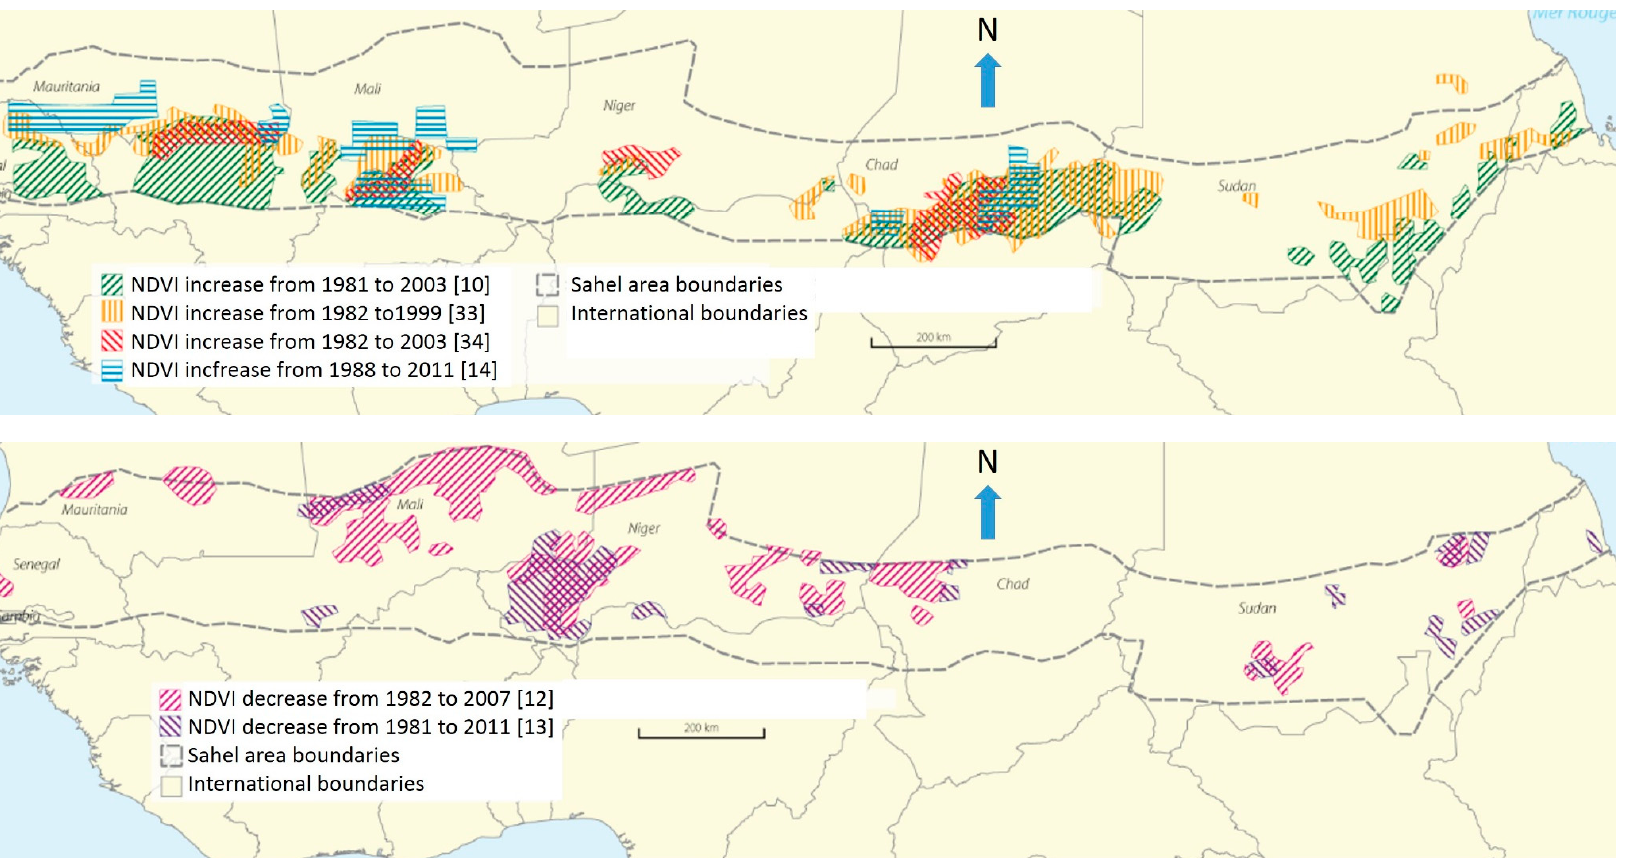
Figure 8. Areas of increasing (up) and decreasing (down) NDVI between the 1980s and the 2000s, according to published research [10,12–14,33,34,82,83,100].